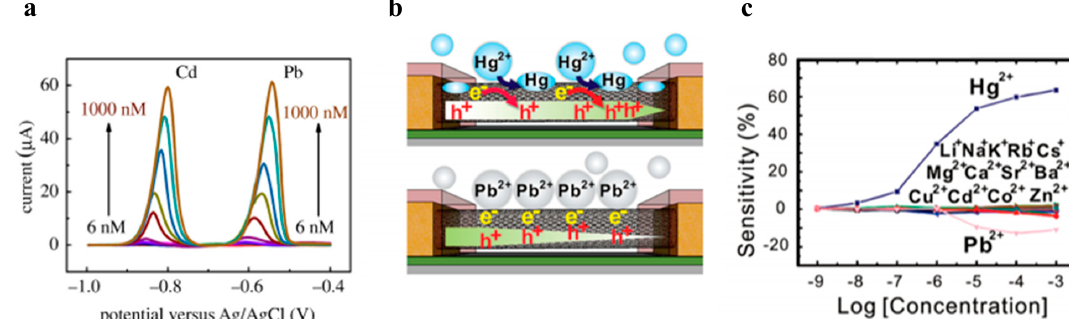
Figure 3. Heavy metal ions detection methods based on differential pulse stripping voltammetry DP-ASV ( a ) and conductance measurements from single − walled carbon nanotube field e ff ect transistor (swCNT − FET) ( b , c ). In more detail, ( a ) calibration curves of the stripping peak currents at carbon black − Nafion − glassy carbon electrode with increased concentrations of Cd(II) and Pb(II) (reproduced from [31]). ( b ) Mechanism of detection for Hg 2 + (upper) and Pb 2 + (lower) by a swCNT − based FET sensor. ( c ) Response to various metal ions with concentrations from 1 nM to 1 mM (reproduced with permission from